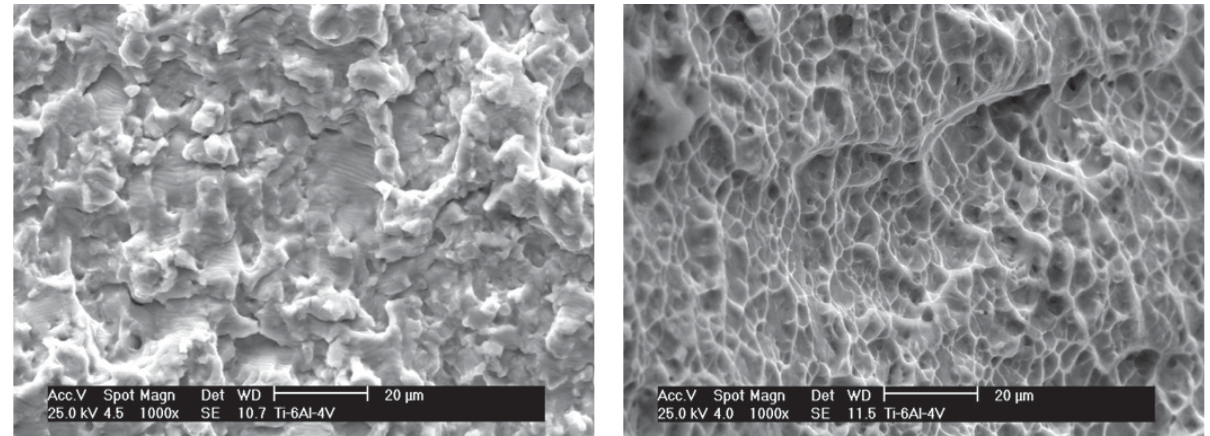
Fig. 9. Fatigue striations are found near the edge of the samples after fatigue failure (left), but the fracture is completely ductile around the middle of the specimen (right).